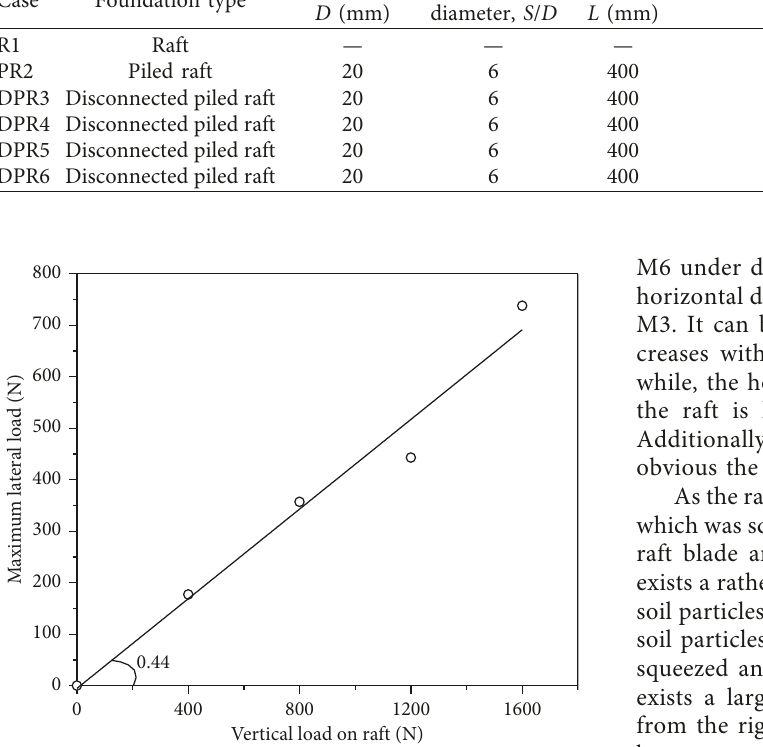
Figure 5: Load-displacement curve of the